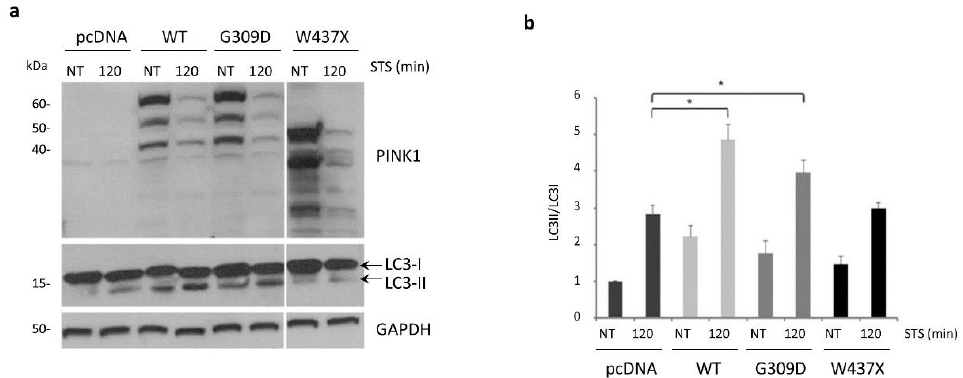
Figure 6. PINK1 – Beclin1 interaction regulates STS-induced autophagy. ( a ) PINK1-silenced (shPINK1) SH-SY5Y cells were transiently transfected with empty vector (pcDNA), PINK1 wild-type (WT), PINK1 G309D or PINK1 W437X, and then treated either with STS or with DMSO for 2 h (NT). Autophagy activation was measured by analyzing the LC3-II/LC3-I ratio. PINK1 expression was verified by immunoblot analysis with an anti-PINK1 antibody. Equal loading was verified by GAPDH protein levels. ( b ) Densitometric analysis of ( a ). Both WT-PINK1 and the G309D mutant significantly rescued autophagy impairment, but not the W437X-PINK1 mutant that is unable to interact with Beclin1 (2.84 ± 0.24 versus 3 ± 0.14) [21]. Experiments performed in triplicate; mean ± S.E.M. *p ≤ 0.05.